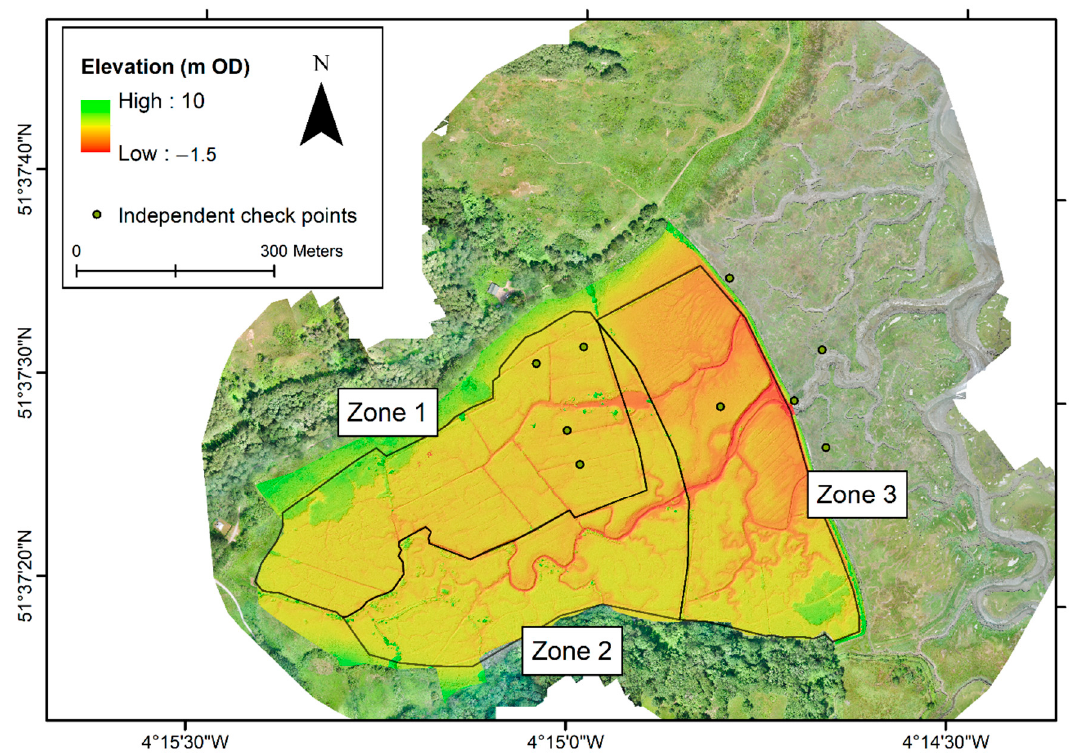
Figure 2. Site elevation (metres above Ordnance Datum (m OD)), the internal individual zones, and the independent model quality check points used in this study. Note that elevation outside the side was calculated and used to assess model quality, but has not been presented here.